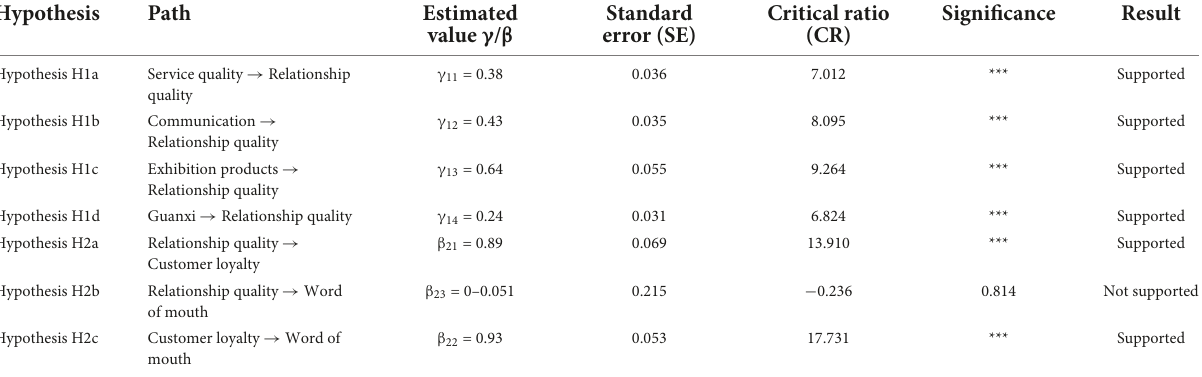
TABLE 7 Standardized test results of potential variable influence